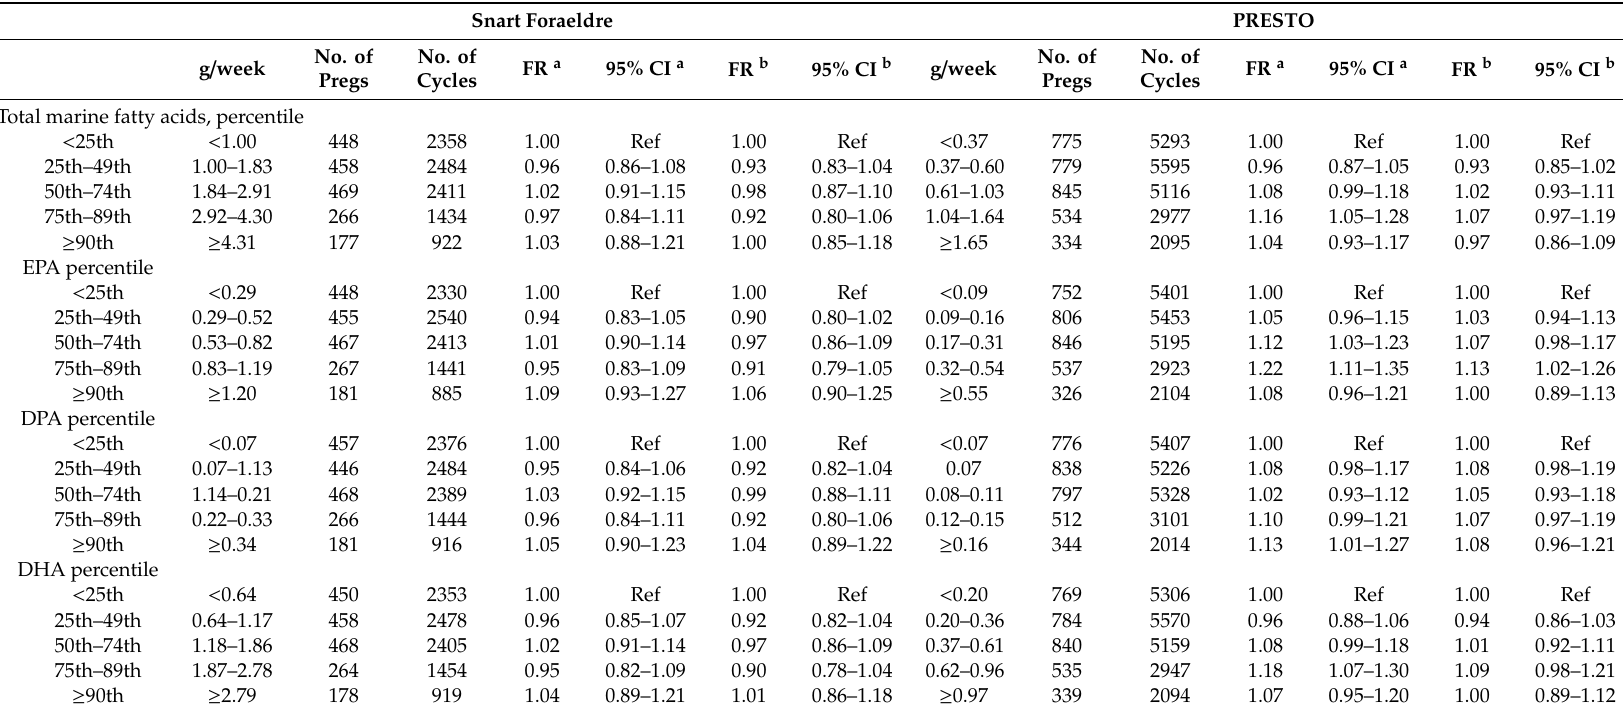
Table 3. Associations between dietary intake of marine-sourced long-chain omega-3 fatty acids and